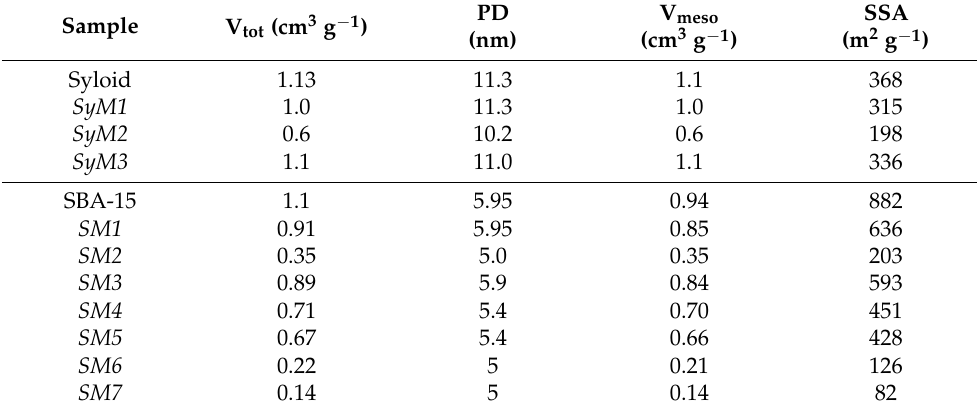
Table 2. Data derived from N 2 gas adsorption/desorption measurement.